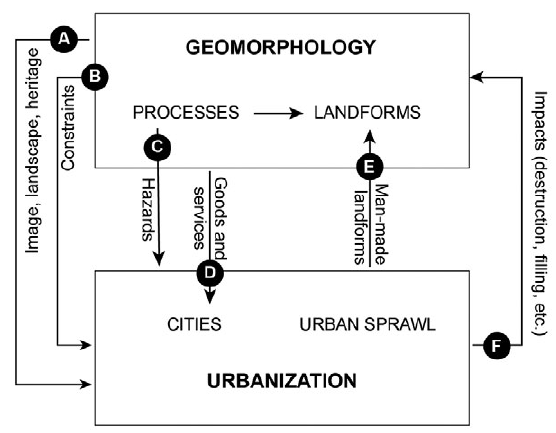
Fig. 1. Relationships between geomorphology and urbanization.